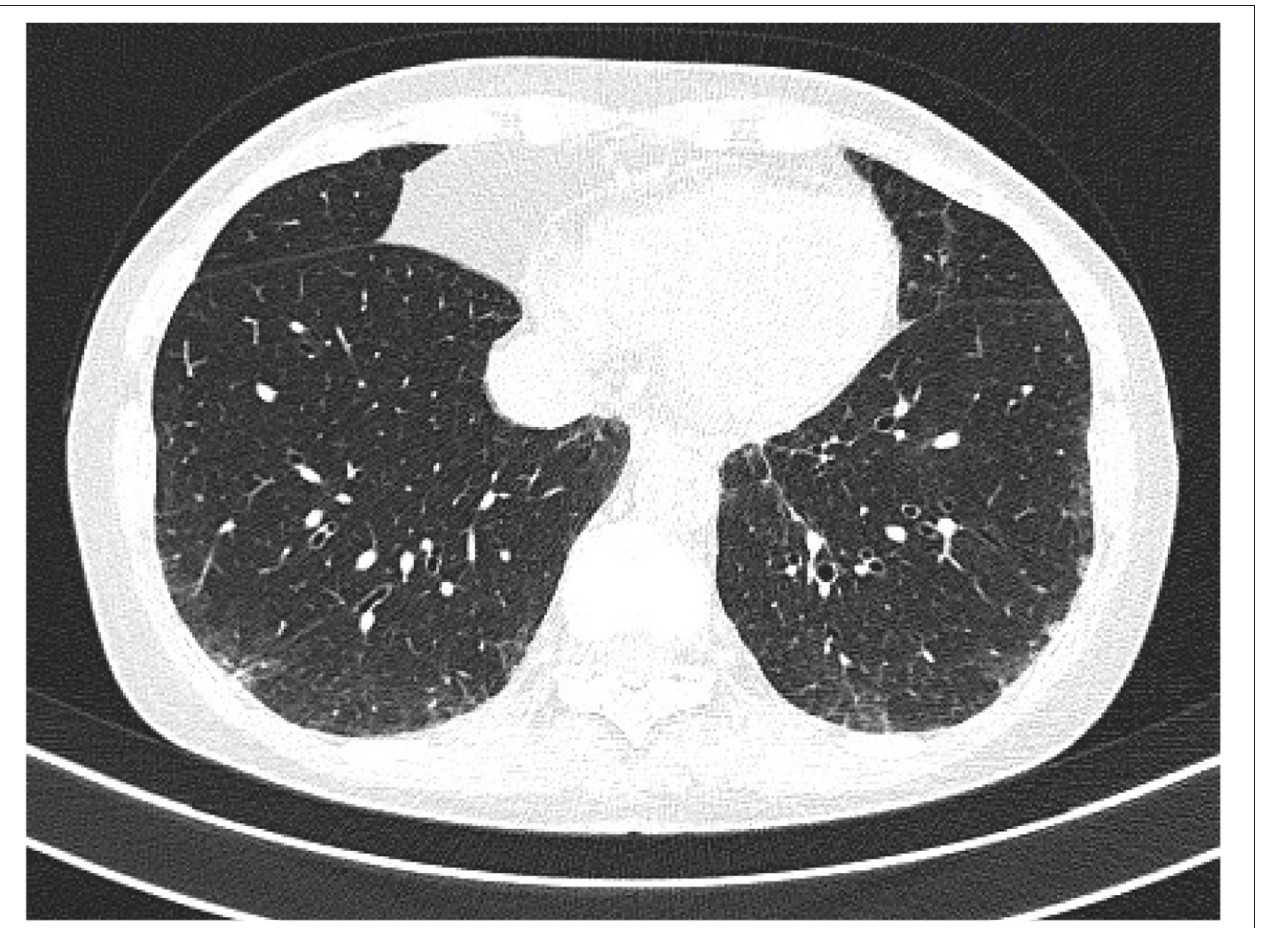
FIGURE 5 | Bronchiectasis (BR) on HRCT in a patient with RA.